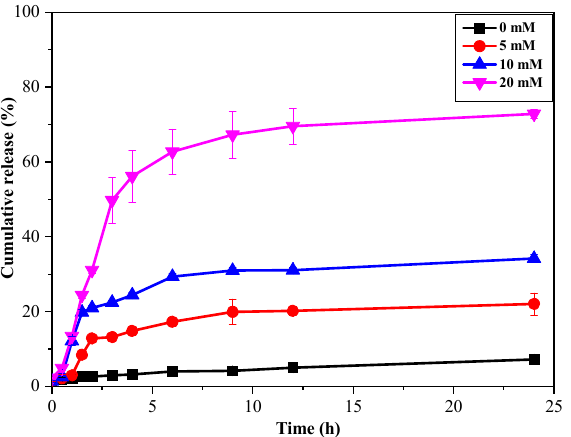
Figure 7. Insulin release profiles from hybrid microgels at different glucose concentrations (0 mM, 5 mM, 10 mM and 20 mM, 37 °C, pH = 7.4).